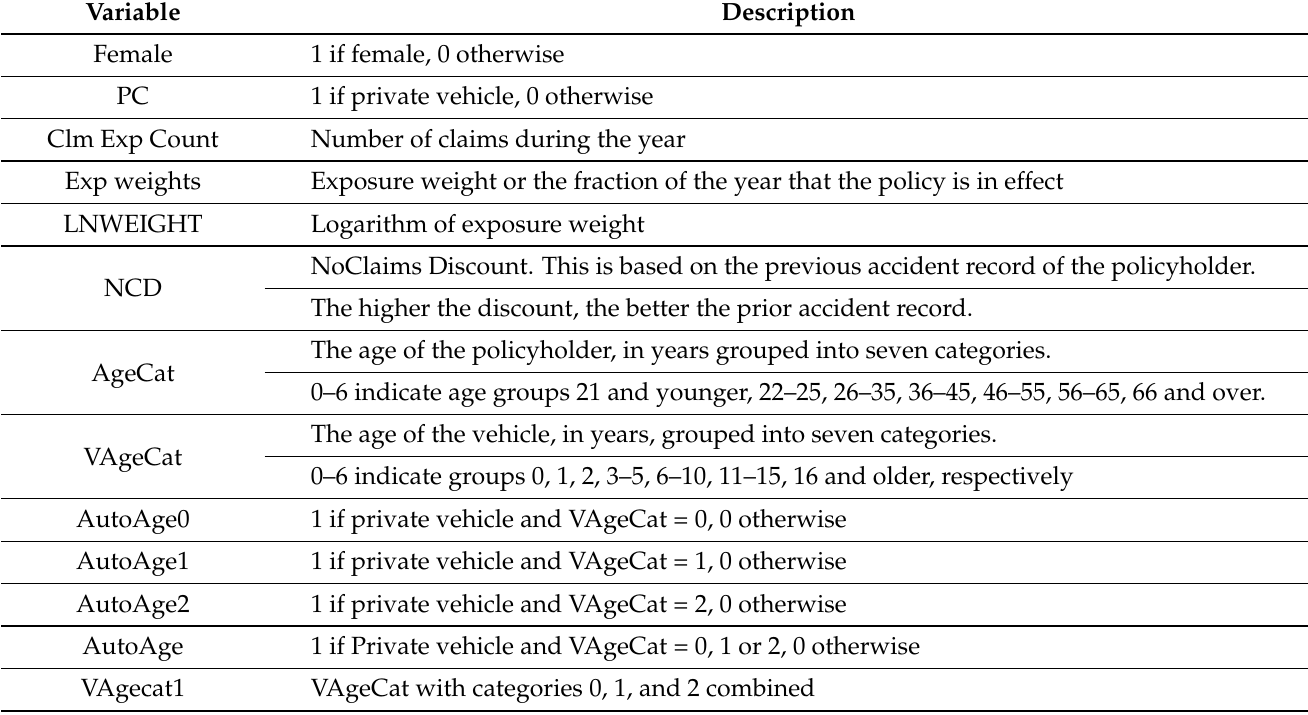
Table 3. Variables and description of Singapore automobile claims